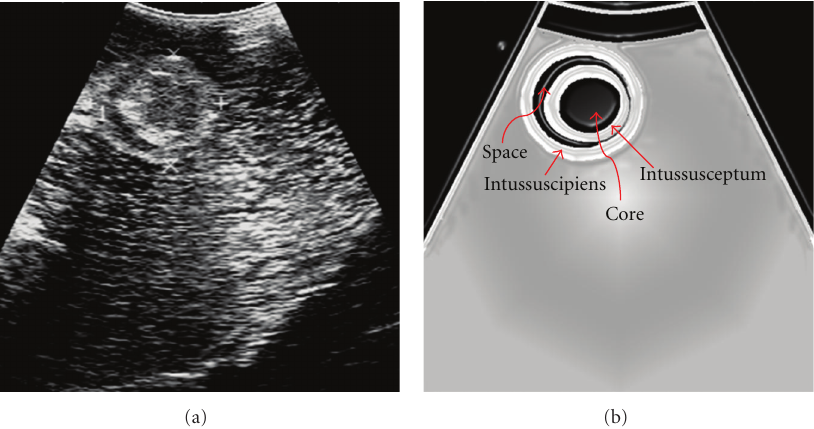
Figure 2: Ultrasonogram of jejunal intussusception imaged transrectum in